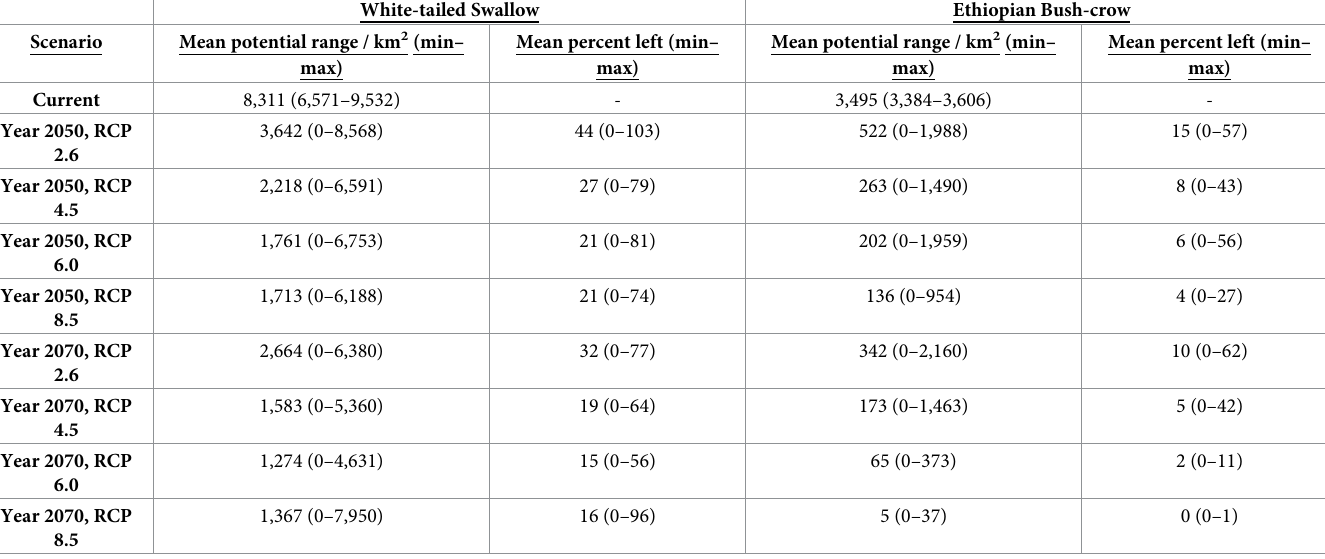
Table 1. The area of mean current and future potential White-tailed Swallow and Ethiopian Bush-crow ranges based upon climate-only SDMs.